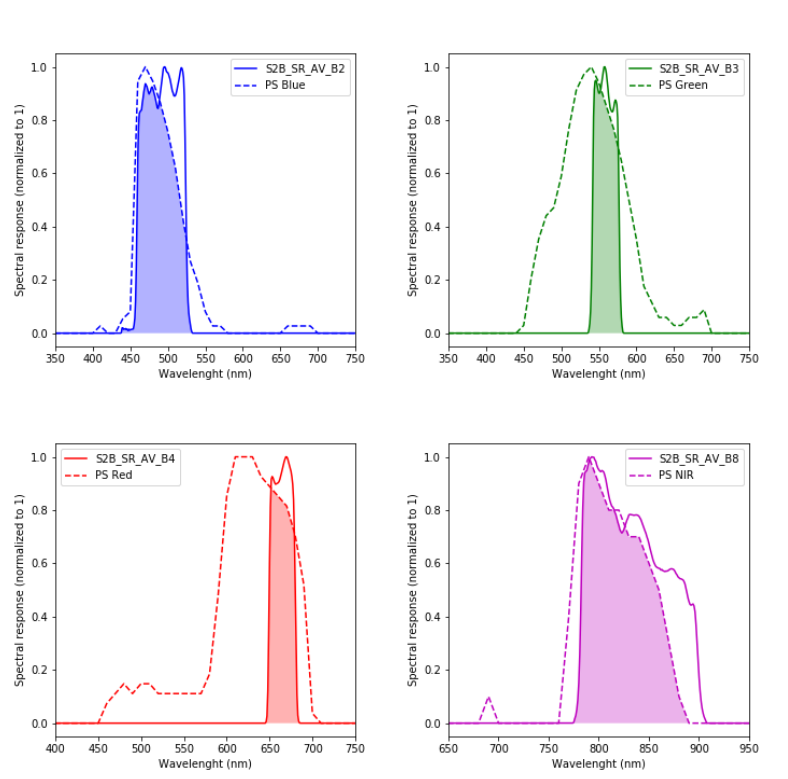
Figure 4. Comparison between PlanetScope (PS) (group 0cxx or 0dxx) and S2 (A) spectral response functions for RGB and near infrared